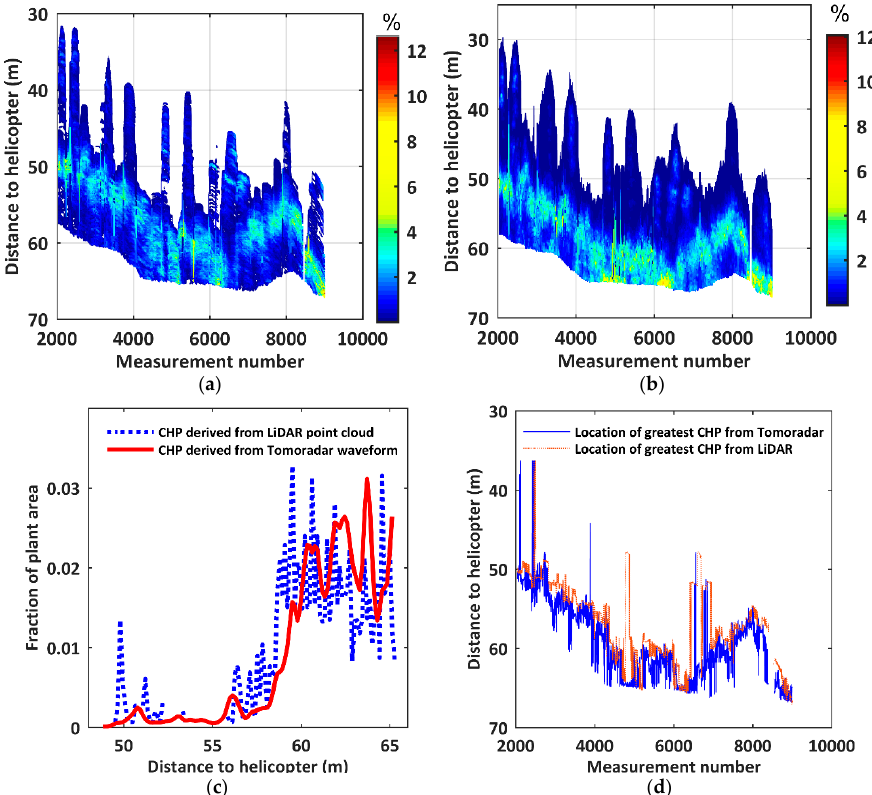
Figure 6. The distributions of CHP for 6676 measurements: ( a ) the CHPs from the LiDAR data; ( b ) the CHPs from Tomoradar waveforms; ( c ) the CHPs from Tomoradar and LiDAR for the 6000th measurement; and ( d ) the locations of greatest CHP.